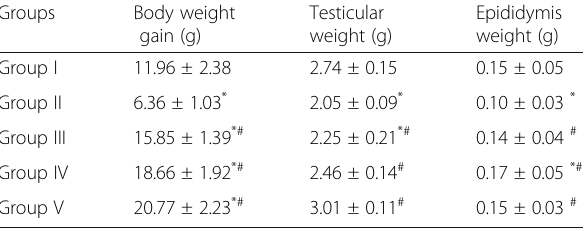
Table 1 Influence of MLVA on body weight gain, testicular and epididymal weight of rats treated with